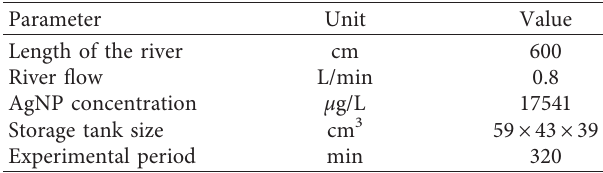
Table 2: Design parameters of the simulated river system.